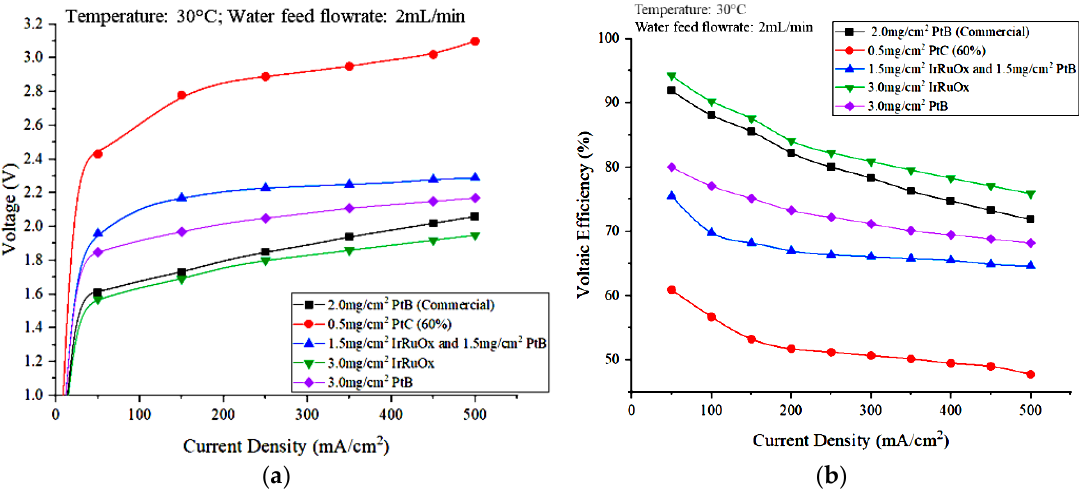
Figure 10. Effects of the anode electrocatalyst type and loading on electrolyzer performance: ( a ) polarization curve that represent the effects and ( b ) effect on voltaic efficiency.